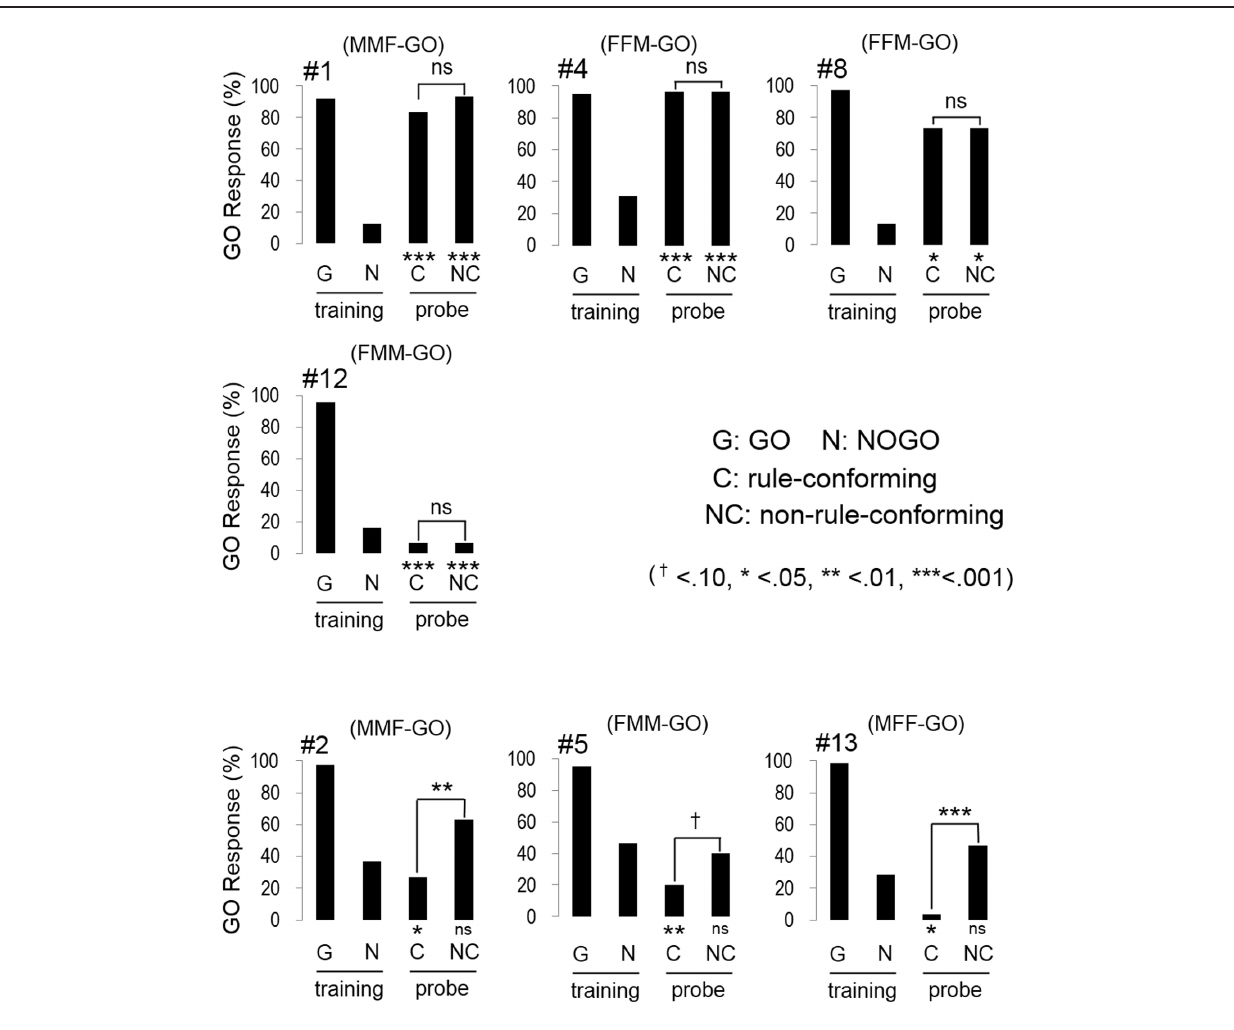
stimulus except GO stimulus. The response of the remaining birds (#2, #5, #13) depended on the type of repetition sounds (e.g., FMM-GO bird showed GO response to MMF probe